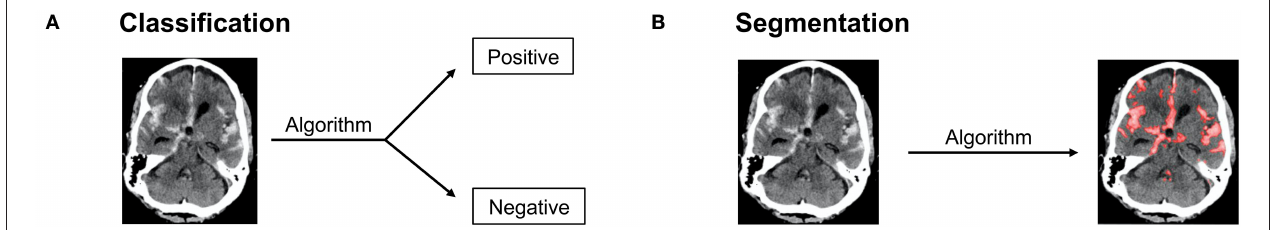
FIGURE 5 | A schematic representation of (A) classification and (B) segmentation algorithmic outputs. In (B) , red regions indicate areas of acute intracranial hemorrhage designated by the algorithm